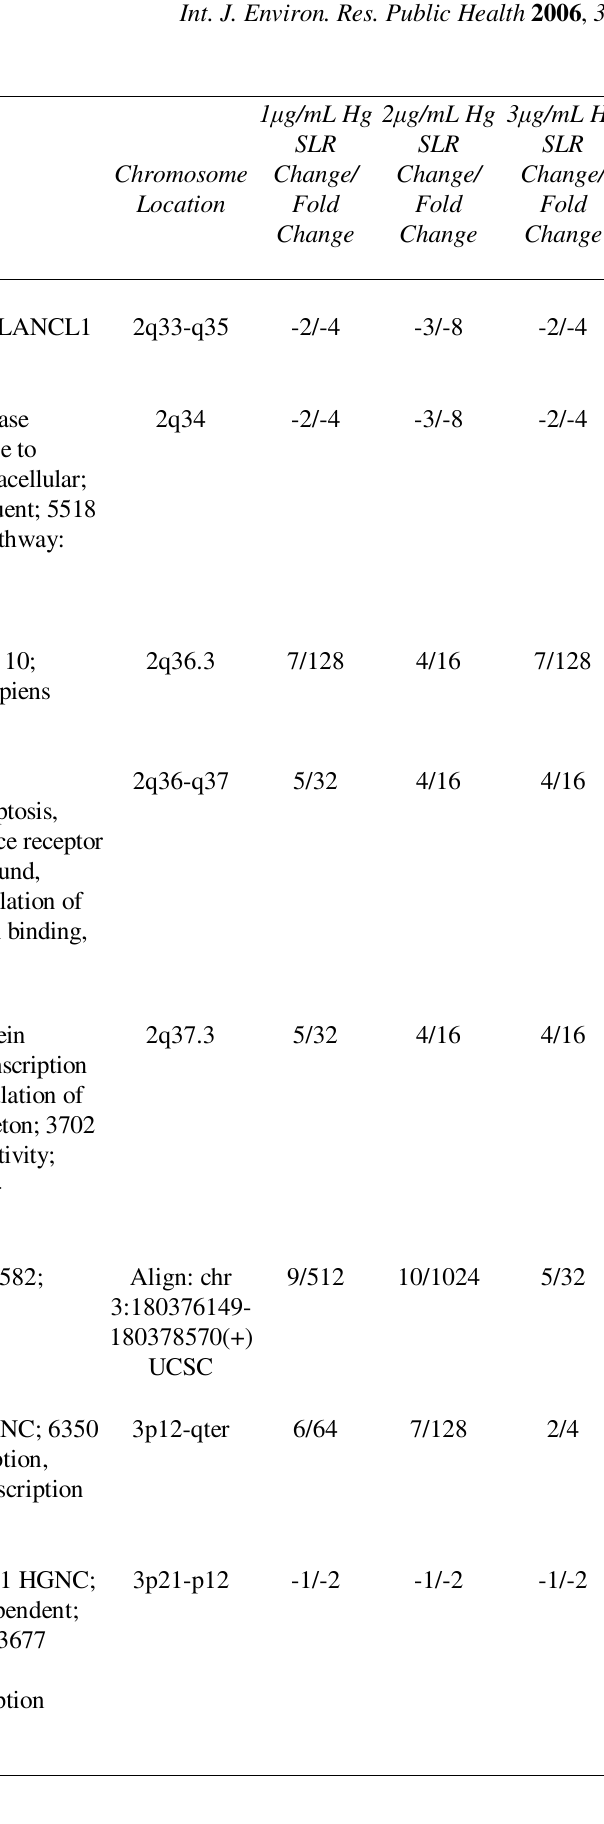
SLR-- signal log ratios